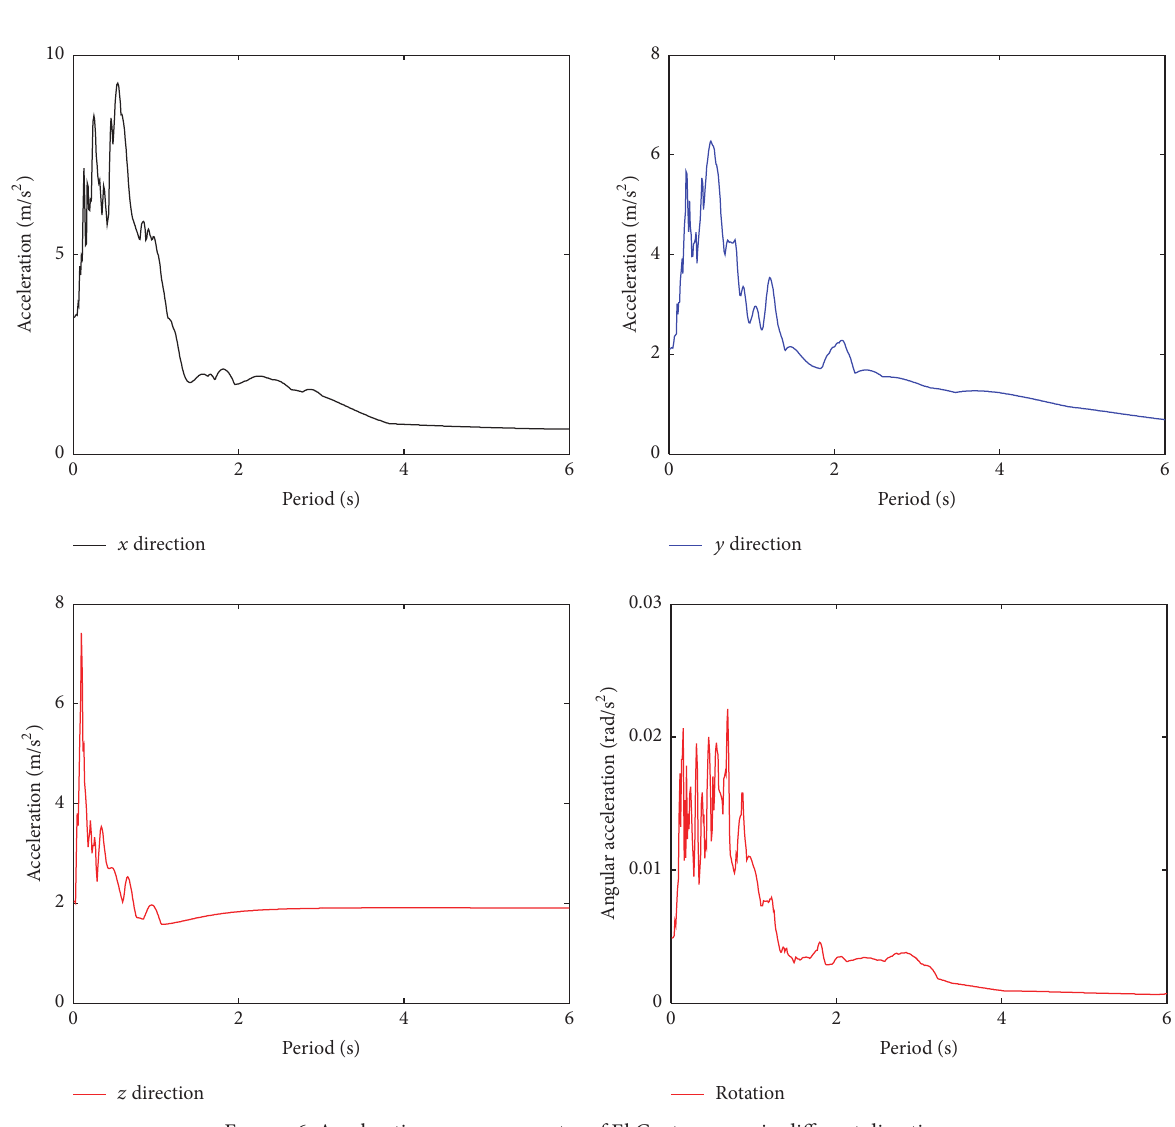
Figure 6: Acceleration response spectra of El Centro waves in different directions.